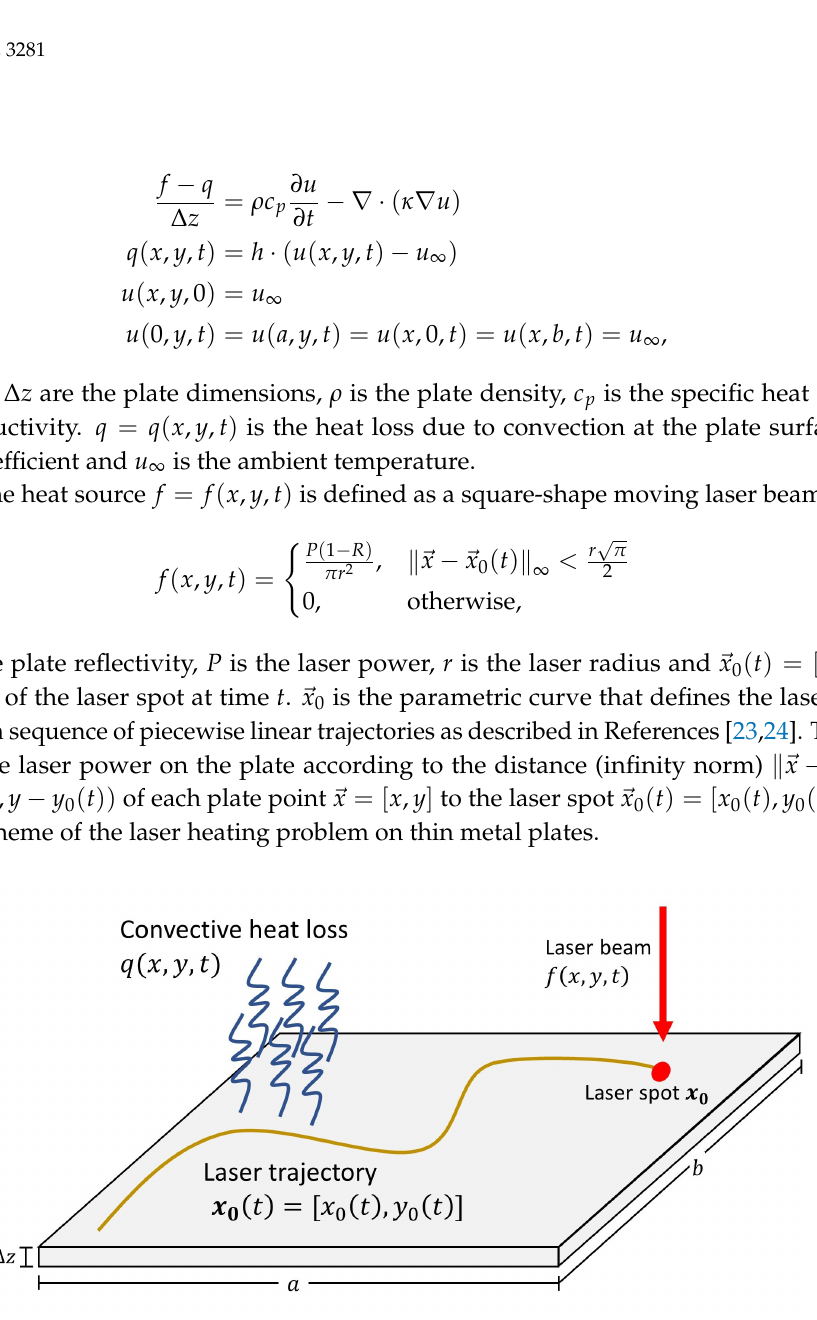
Figure 1. Scheme for the laser heating problem on thin metal